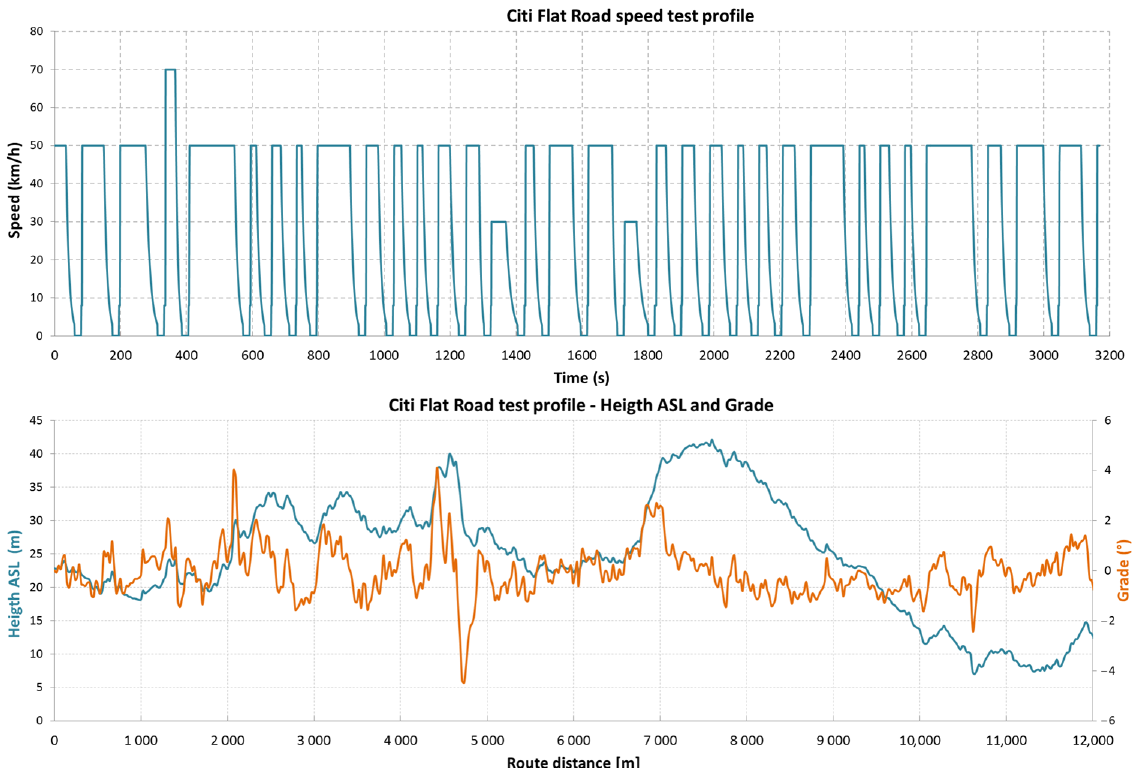
Figure 9. City Flat Road test profile (speed, absolute altitude, and grade).